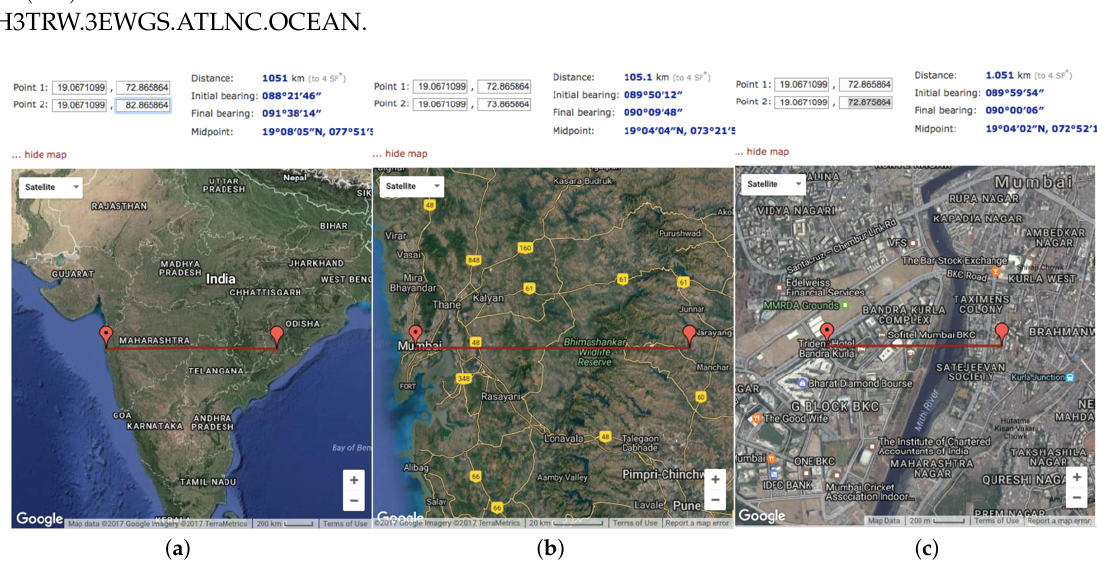
Figure 9. Coordinate Approximation. ( a ) Tens digit corresponding to 1000 km; ( b ) units digits corresponding to 100 km; and ( c ) hundredth digit corresponding to 1